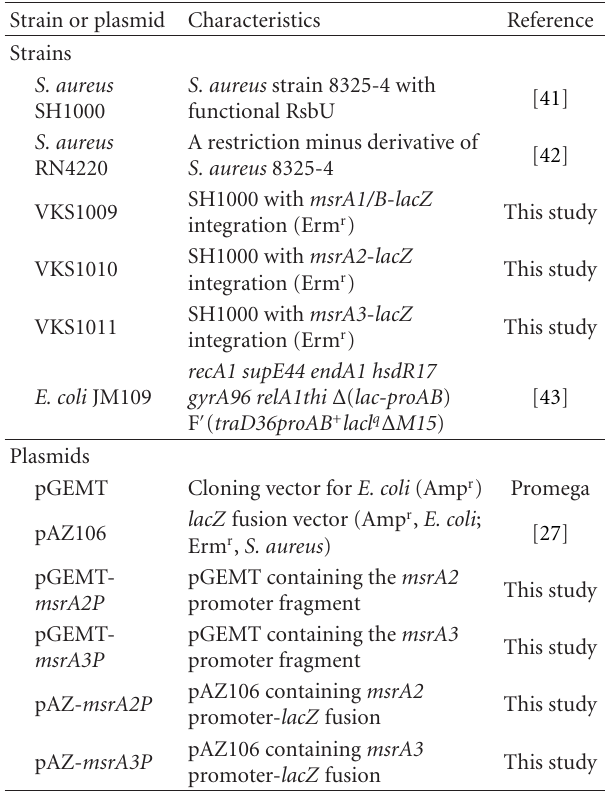
Table 1: Bacterial strains and plasmids used in this